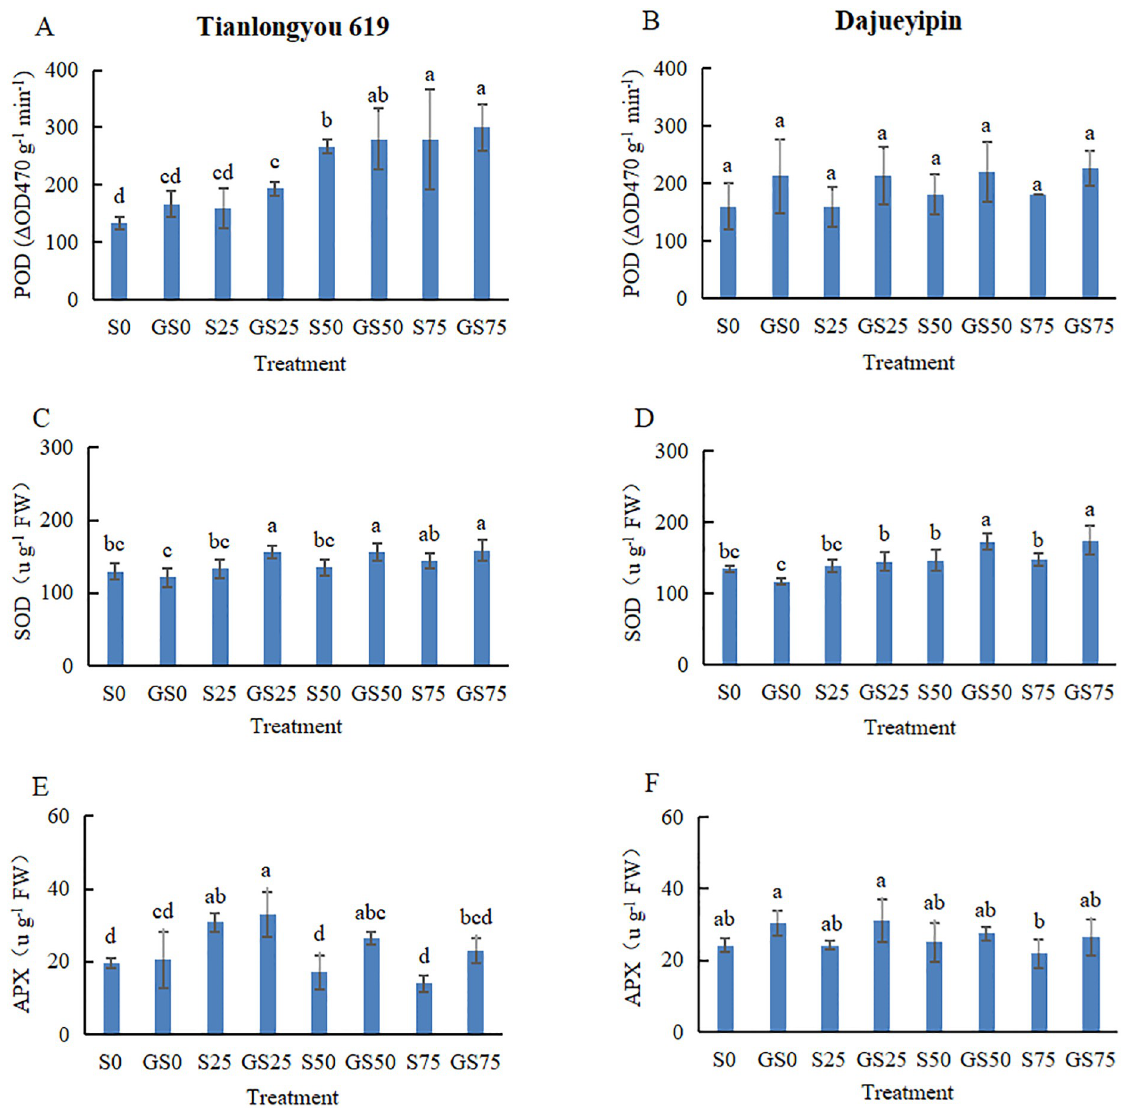
Fig 4. Assessment of antioxidant enzyme activities in rice leaves under different salt or/and GABA treatments.